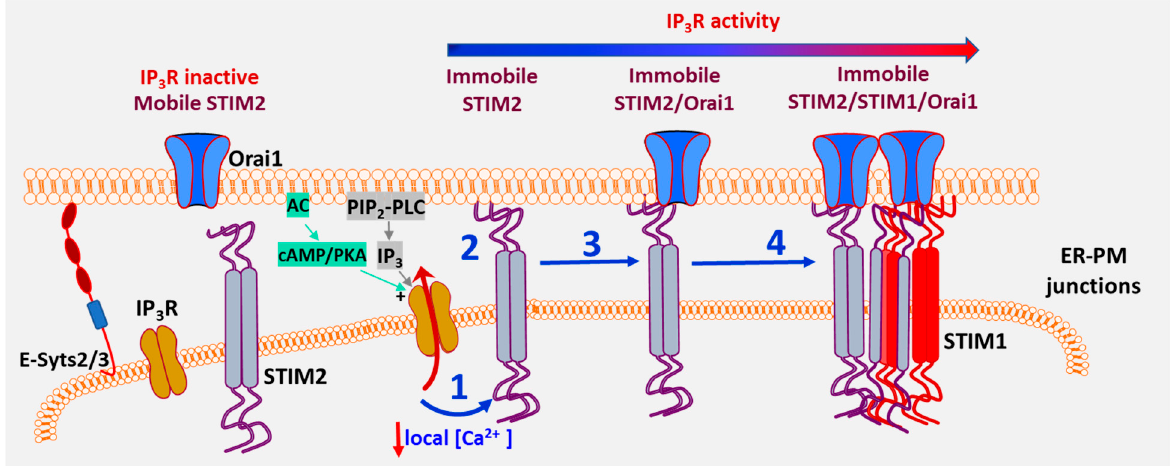
Figure 2. Functional communication between IP 3 R and STIM2 at subthreshold stimuli is a critical checkpoint for initiation of SOCE. The model refers to cellular responses under ambient and low-intensity stimuli. IP 3 R and STIM2 are localized in the ER–PM junctional region. Under ambient conditions (without agonist addition), constitutive PLC-dependent PIP 2 hydrolysis as well as cAMP/PKA activity regulate IP 3 R activity. When STIM2 is in the vicinity of a functional IP 3 R, it senses the lower [Ca 2+ ] ER (1), which leads to scaffolding to the plasma membrane and immobilization (2). Orai1 is then recruited to immobile STIM2 (3) and with further [Ca 2+ ] ER decrease STIM1 is also recruited to immobile STIM2 (4) [5] .